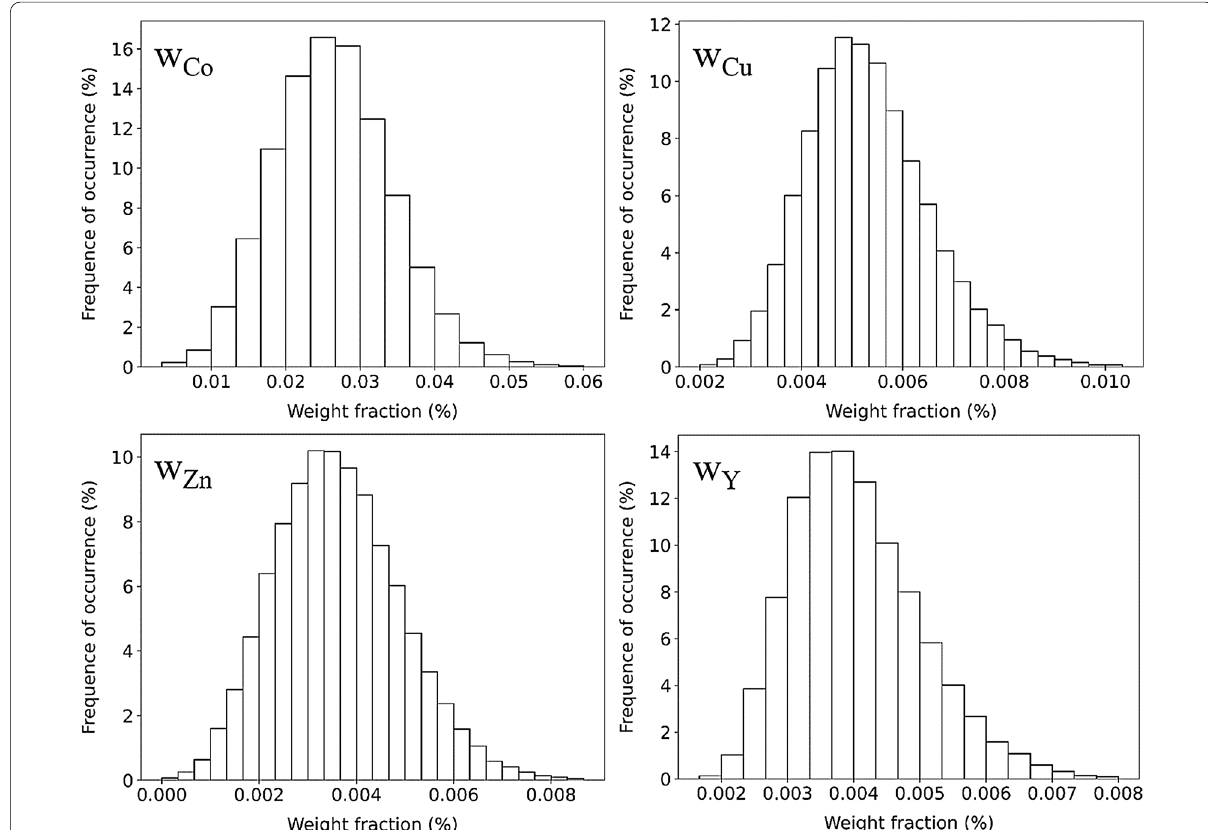
Fig. 8 Weight fraction (wt%) distributions for Co, Cu, Zn, and Y for apatite #7 of Ryugu section C0033‑04 using 50,000 Monte Carlo